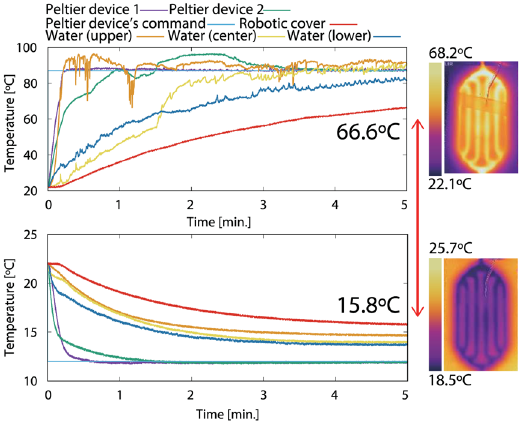
Figure 5. The controllable temperature range of the robotic cover surface. The Peltier devices are controlled to maximum and minimum temperatures in our experimental setup (87 °C and 12 °C, see Supplementary Note S2). The temperature responses of the water (lower, middle, upper side of the tank) and that of the cover are monitored. The robotic cover surface is successfully cooled and heated from 15.8 to 66.6 °C. This range covers the temperature that are comfortable for humans 18,19,64 .